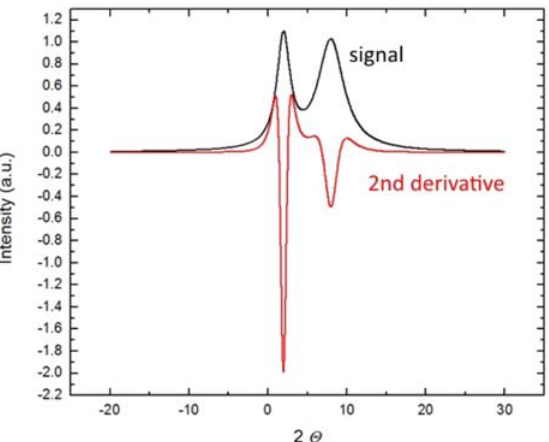
Figure 5. Synthesized profile, consisting of two overlapped profi- les, labeled in black. 2 nd derivative of the profile, labeled in red. 2 nd derivative is scaled so as to give the positive values in the whole range, when subtracted from the